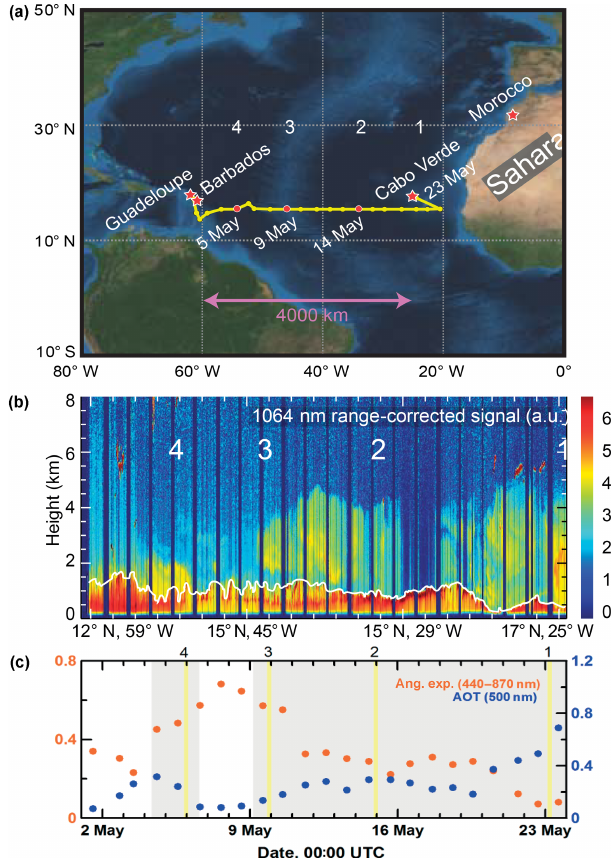
Figure 1. (a) Cruise track of the R/V Meteor from Guadeloupe (29 April 2013) to Cabo Verde (23 May 2013) plotted as a thick yellow line (Kanitz et al., 2014). The SAMUM-1 (Morocco), SAMUM-2 (Cabo Verde), and SALTRACE (Barbados) field sites are marked by red stars. Red circles and dates (5, 9, 14, and 23 May) indicate the locations of four lidar observations (cases 1, 2, 3, and 4) discussed in detail in this paper and the follow-up article. (b) Dust- free marine aerosol layer (MAL, top height as a white line) and lofted Saharan air layer (SAL). The composite is based on lidar measurements of the range-corrected 1064nm backscatter signal. Measurement breaks around 12:00LT (dark vertical lines) are due to high sun elevation and shutdown of the lidar. (c) Time series of daily mean sun photometer observations of aerosol optical thick- ness (AOT) (blue circles) and Ångström exponent (orange circles). The gray-shaded areas indicate time periods with lofted dust. The yellow vertical lines indicate the selected four observational